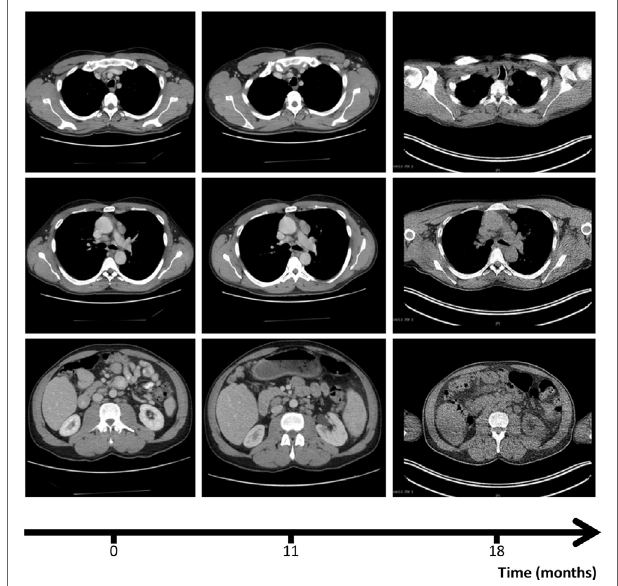
FIgURe 1 | Computer tomography (CT) scans, revealing axillary (upper row), mediastinal (mid row), and abdominal lympadenopathy (lower row) at the three different time points: diagnosis of disseminated infection with Bacillus Calmette–Guérin (0, left column), escalation of antimycobacterial therapy (11, mid column), and diagnosis of Sjögren’s syndrome (18, right column). CT scan of right row was performed in the context of a positron emission tomography/CT (see Figure 4